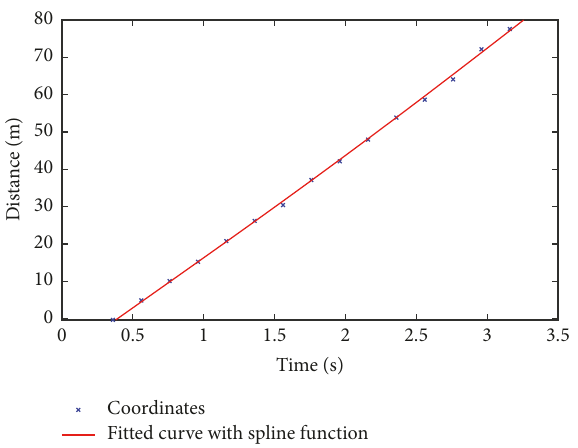
Figure 5: A vehicle trajectory with crosses being originally chosen positions and the line being the fitted smoothing spline, which was used for a new oversampling.